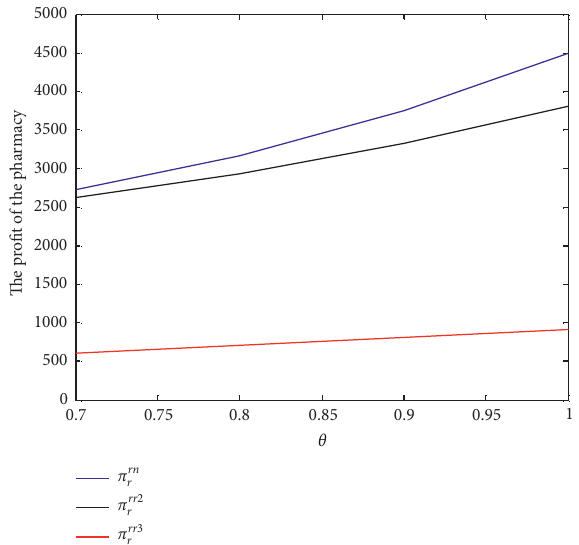
Figure 2: The profit of the pharmacy under retailer price cap